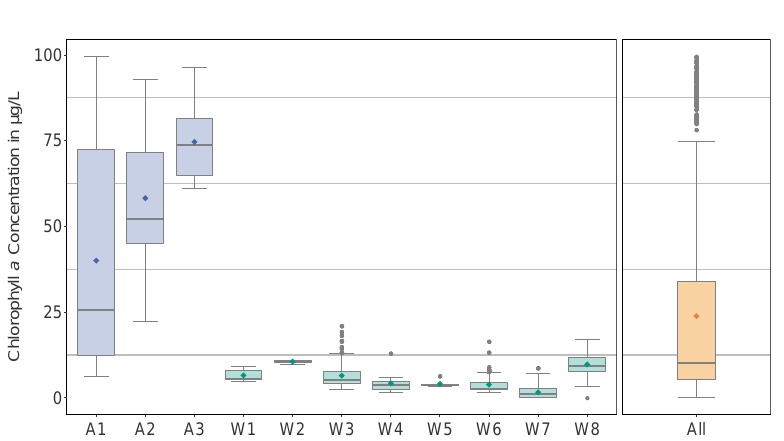
Figure 1. Boxplots of the chlorophyll a concentration range for each inland water body individually, and for all water bodies of the SpecWa dataset. The water ID is given in Table 1. The diamonds in the boxes symbolize the respective mean, the lines the respective median value. The lower limit of each box is the 25th percentile ( Q 1), the upper limit the 75th percentile ( Q 3) so that the difference builds the interquartile range ( IQR ). Whiskers extend to Q 1 − 1.5 ∗ IQR and Q 3 + 1.5 ∗ IQR . Any points beyond the whiskers are outliers and are plotted as